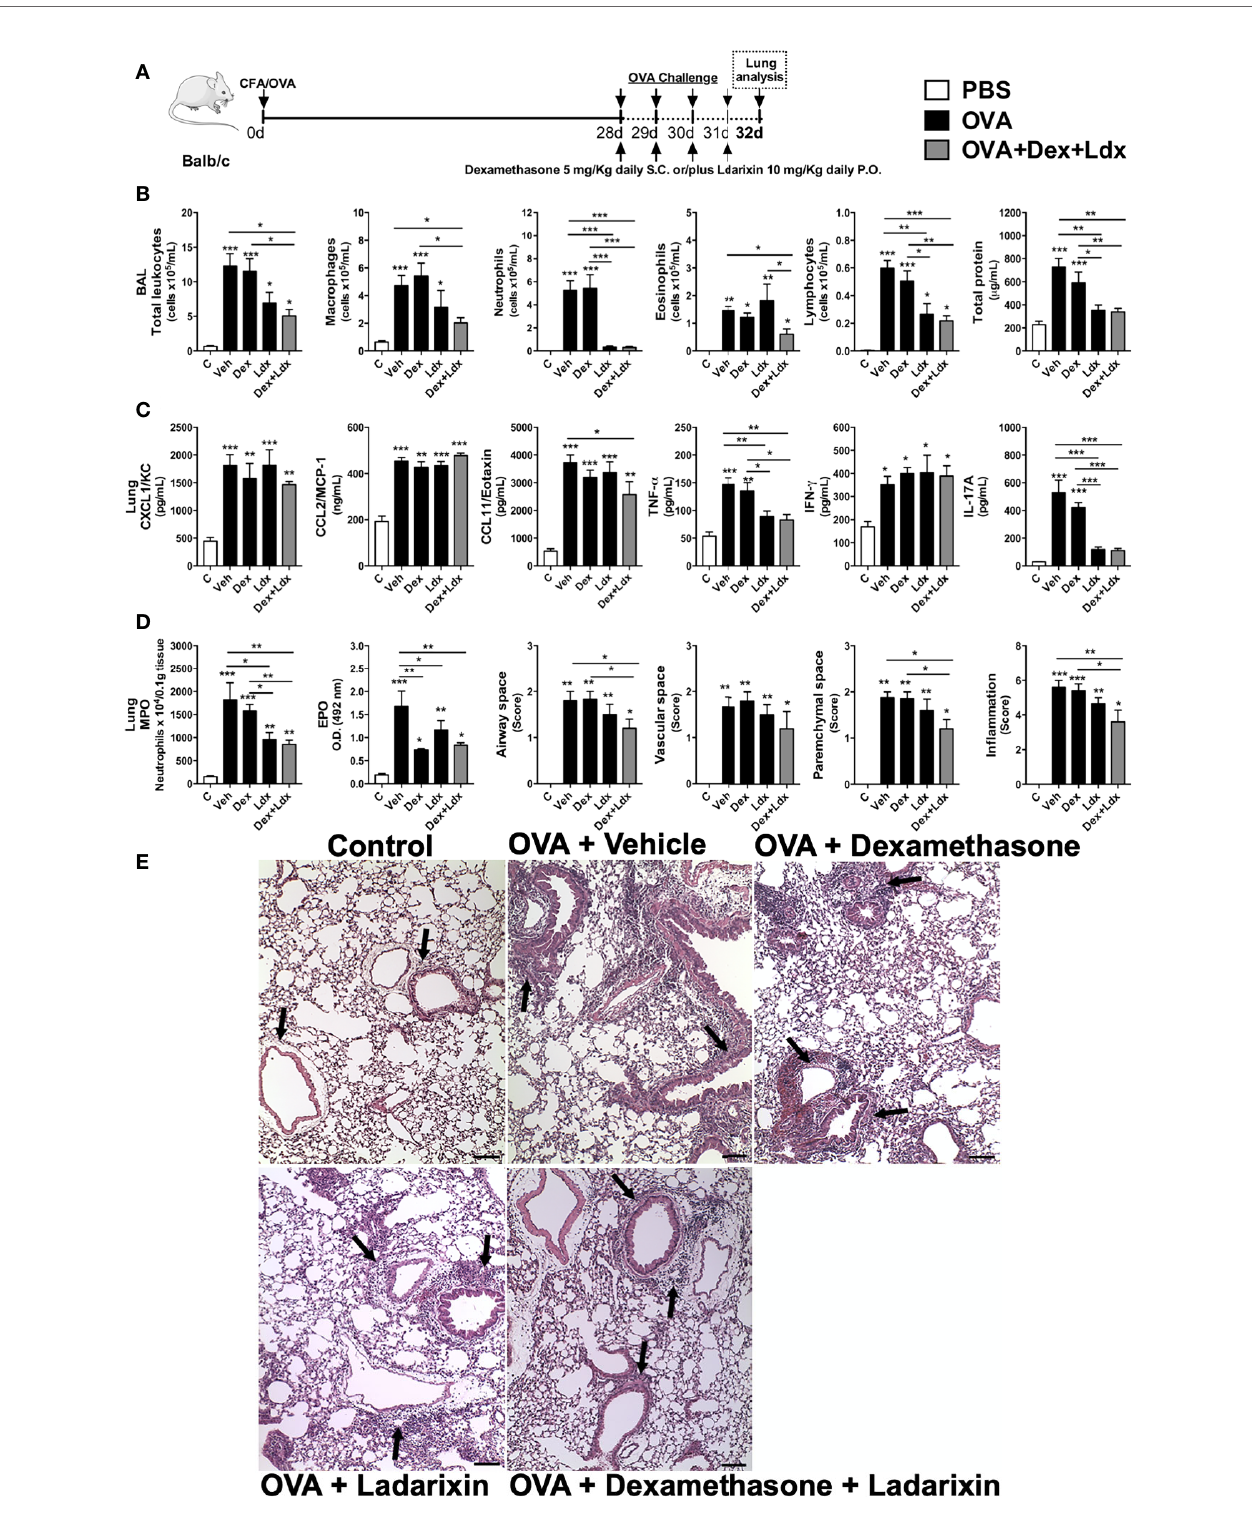
FIGURE 8 | Ladarixin treatment decreases pulmonary in fl ammation in an acute Th1/Th17 glucocorticoid-refractory neutrophilic asthma model. In fl ammatory parameters were evaluated after four daily challenges with OVA. (A) Schematic representation of the experimental design. (B) Assessment of leukocyte in fl ux and blood leakage into airways. (C) Chemokine and cytokine levels in lung parenchyma. (D) MPO and EPO activity quanti fi cation and pulmonary in fl ammation score. (E) Histological sections of lung (H&E dye). Arrows indicate peribronchial in fl ammation. n = 8 for each group, * for P < 0.05; ** for P < 0.01 and *** for p <